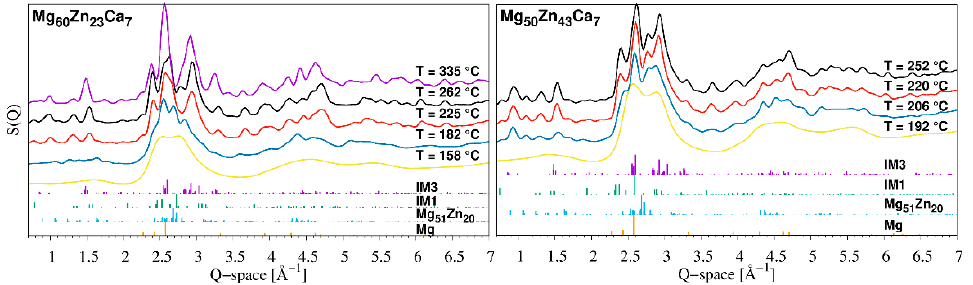
Figure 7. The selected S ( Q ) curves for Mg 60 Zn 33 Ca 7 (left and Mg 50 Zn 43 Ca 7 (right) obtained at different temperatures (indicated by legend) together with relative intensity plots of proposed crystalline phases IM3, IM1, Mg 51 Zn 20 , and hcp-Mg from top to bottom (indicated by legend). Individual S ( Q ) curves are vertically offset for clarity reasons.